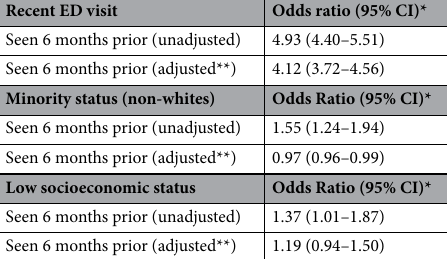
Table 4. Mortality risk based upon recent emergency department (ED) visit, minority and socioeconomic status. *Odds of death comparing cases with controls using logistic regression. **Adjusted for age, gender, race, SES, drug use, alcohol use, tobacco use, & Charlson